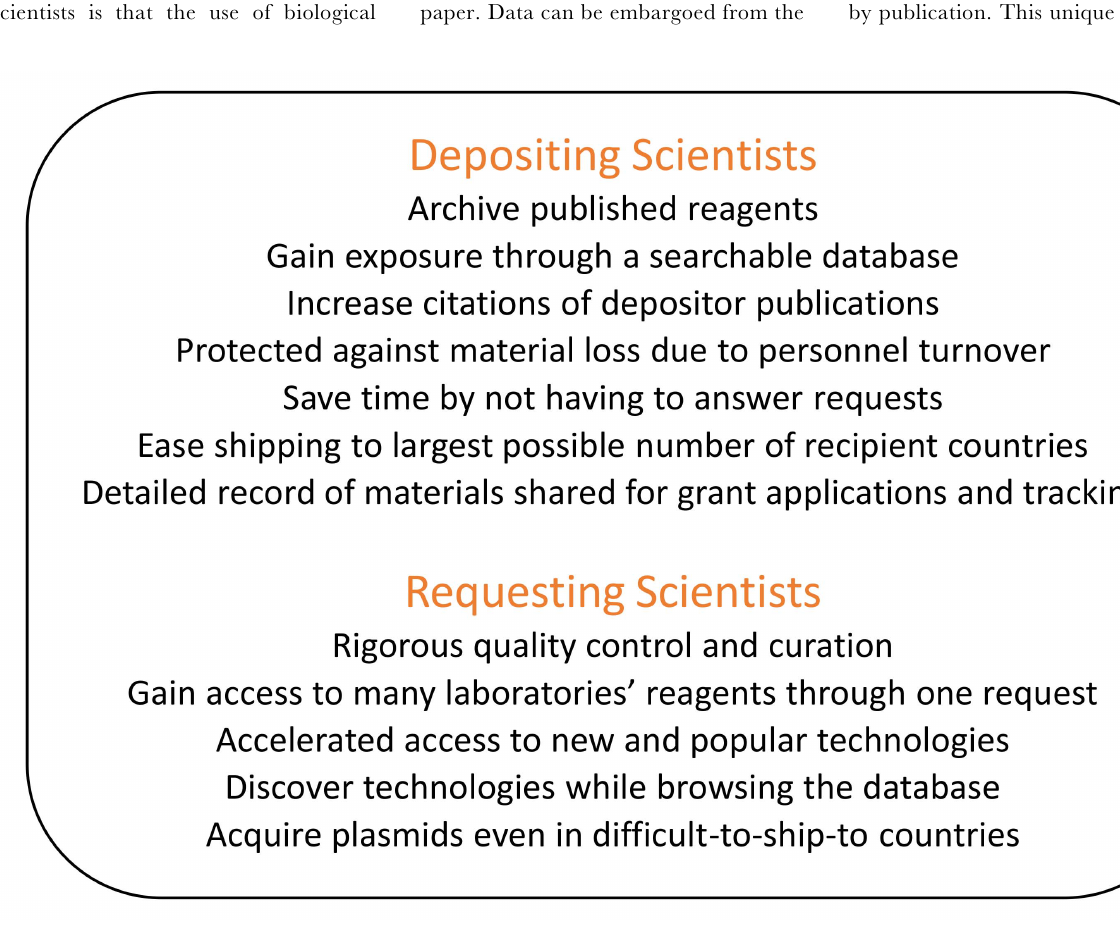
Figure 1. Benefits of sharing materials via a biological resource center. doi:10.1371/journal.pbio.1001991.g001 PLOS Biology |